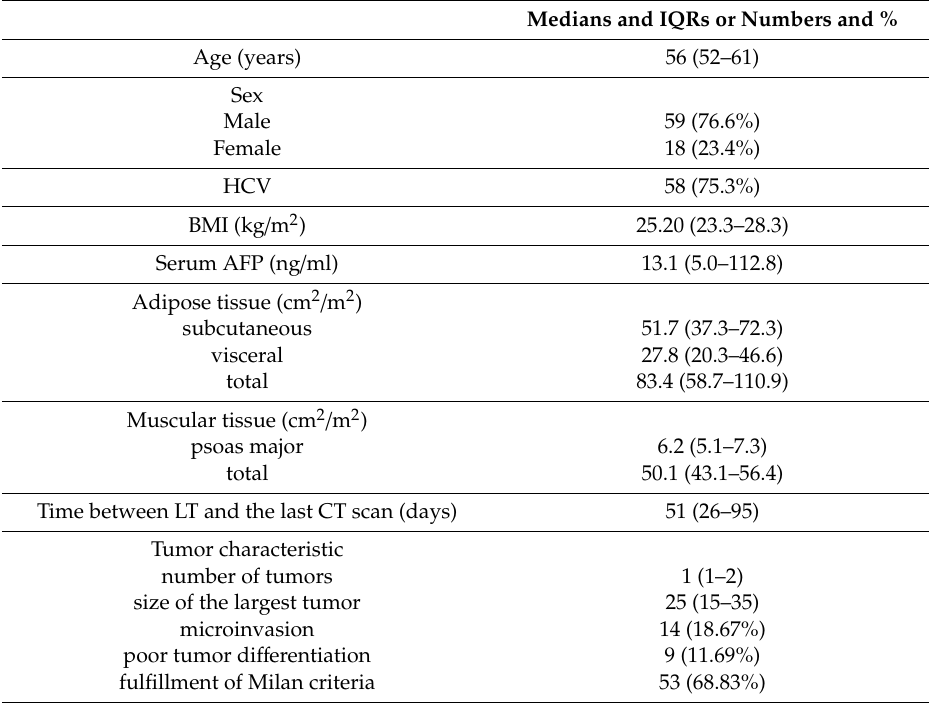
Table 1. Baseline characteristics of the study